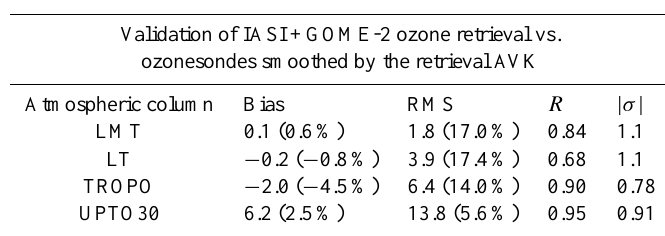
Table 2. Validation of IASI+GOME-2 ozone retrievals against ozonesonde measurements smoothed by IASI+GOME-2 averaging kernels. We consider 105 ozonesondes launched between June and August 2009 from 10 stations over Europe. Cloudy pixels and aberrant satellite retrievals (both for the multispectral and the single-band approaches) are screened out. The comparison is expressed in Dobson units (DU) and in percentage (in parenthesis) in terms of mean bias, RMS differences, linear correlation coefficients R and retrieval standard deviations normalized by those of ozonesonde measurements | σ | .